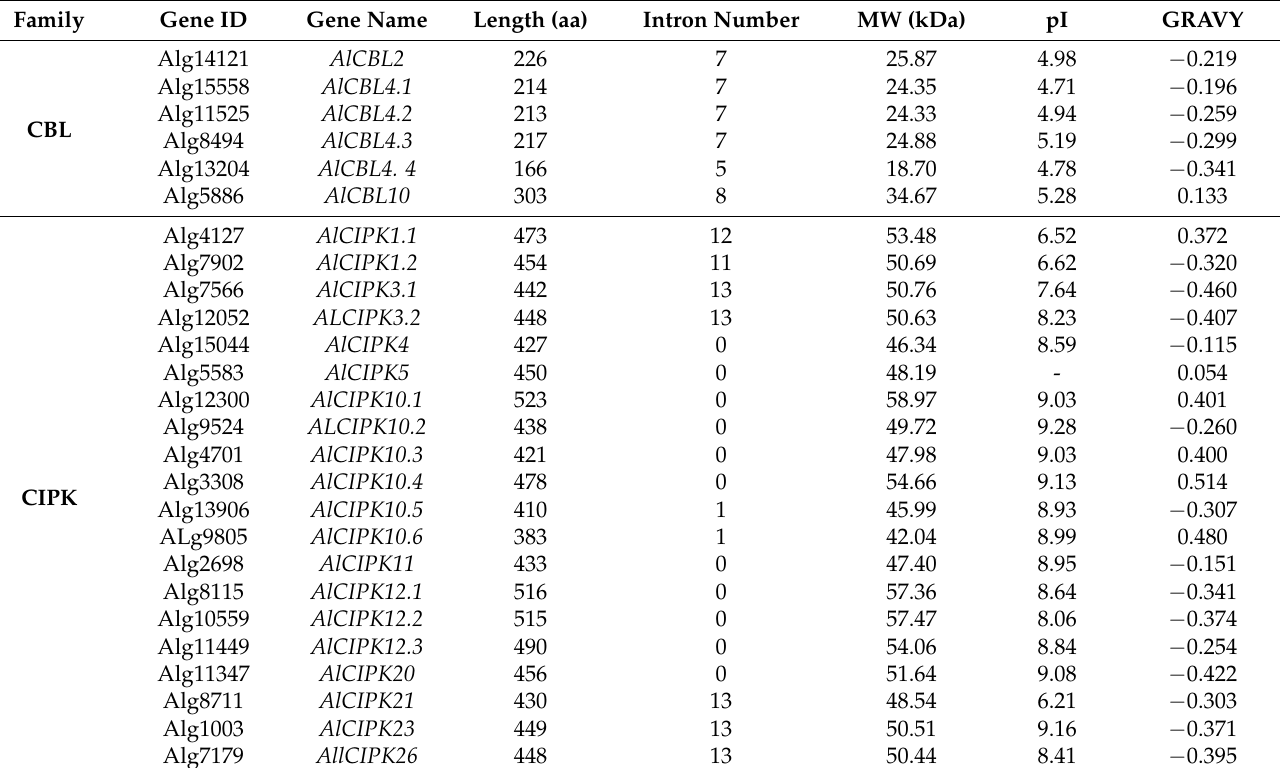
Table 1. Physicochemical properties of identified AlCBL and AlCIPK encoded proteins from A. littoralis